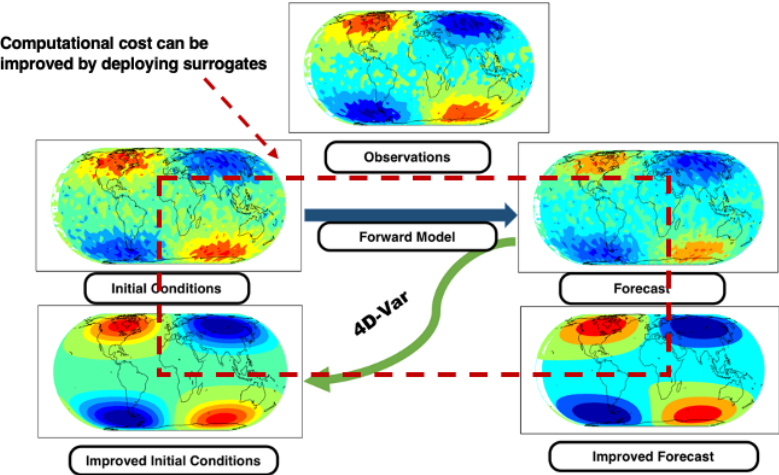
Figure 2. A schematic for 4D-Var. Performing 4D-Var improves the initial conditions of the system, which in turn improves the forecasts. However, 4D-Var requires simulating the expensive model multiple times, and this cost can be mitigated by deploying